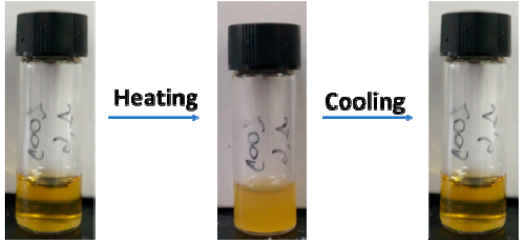
Figure 10. Images of the nanocomposite in H 2 O before and after LCST.